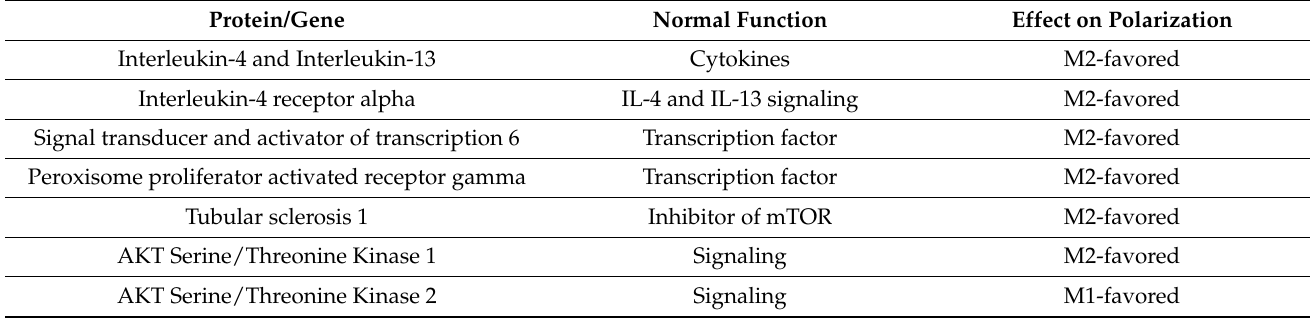
Table 2. Overview of extrinsic mechanisms of macrophage